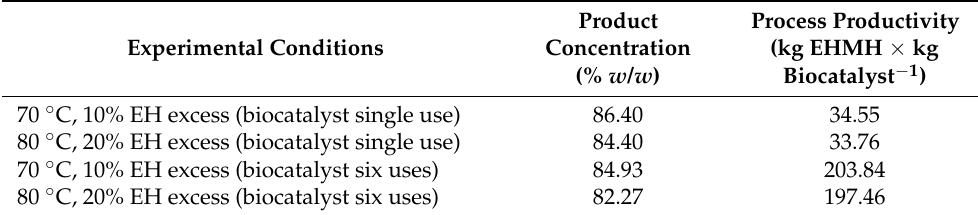
Table 2. Product concentrations (% w/w) and productivity of the enzymatic synthesis of EHMH at 70 °C, 10% EH molar excess and at 80 °C, 20% EH molar excess, both with a single use and with six uses of the biocatalyst.